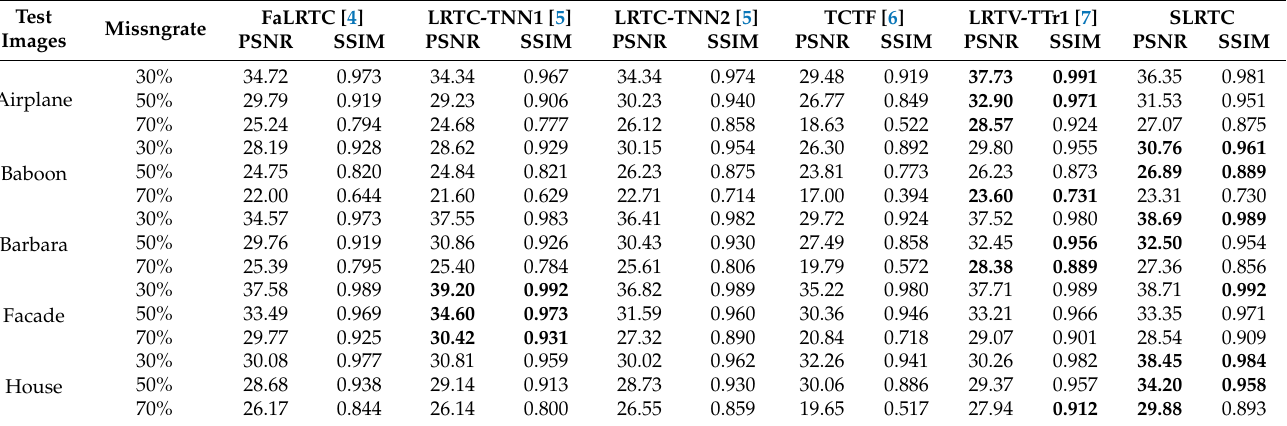
Table 1. The PSNR and SSIM Comparison of different methods on nine images (The best results are